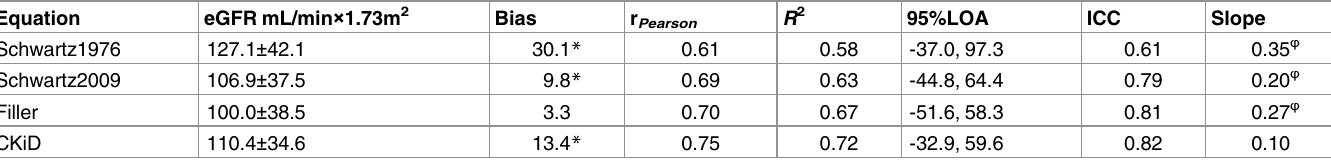
Table 3. Correlation and precision of GFR estimation by different equations. Equation